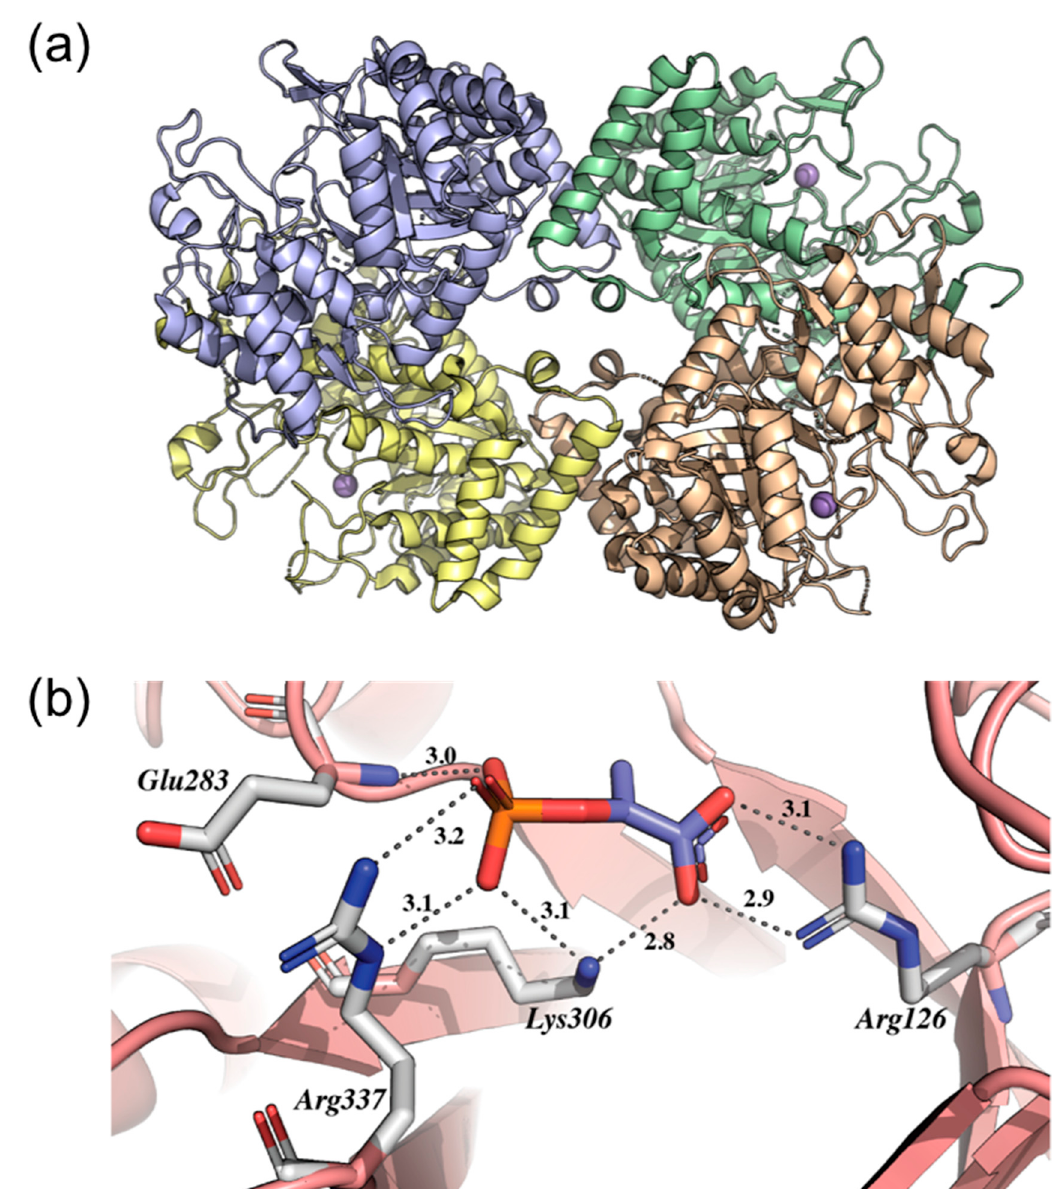
Figure 4. The structure of Mt DAHPS. ( a ) Structure of the Mt DAPHS tetramer showing monomeric units. Mn 2+ ions at the Mt DAHPS active site are shown as purple spheres. ( b ) Active site of Mt DAHPS showing the interactions with the PEP substrate (orange and purple stick model). The images were generated on PyMOL.